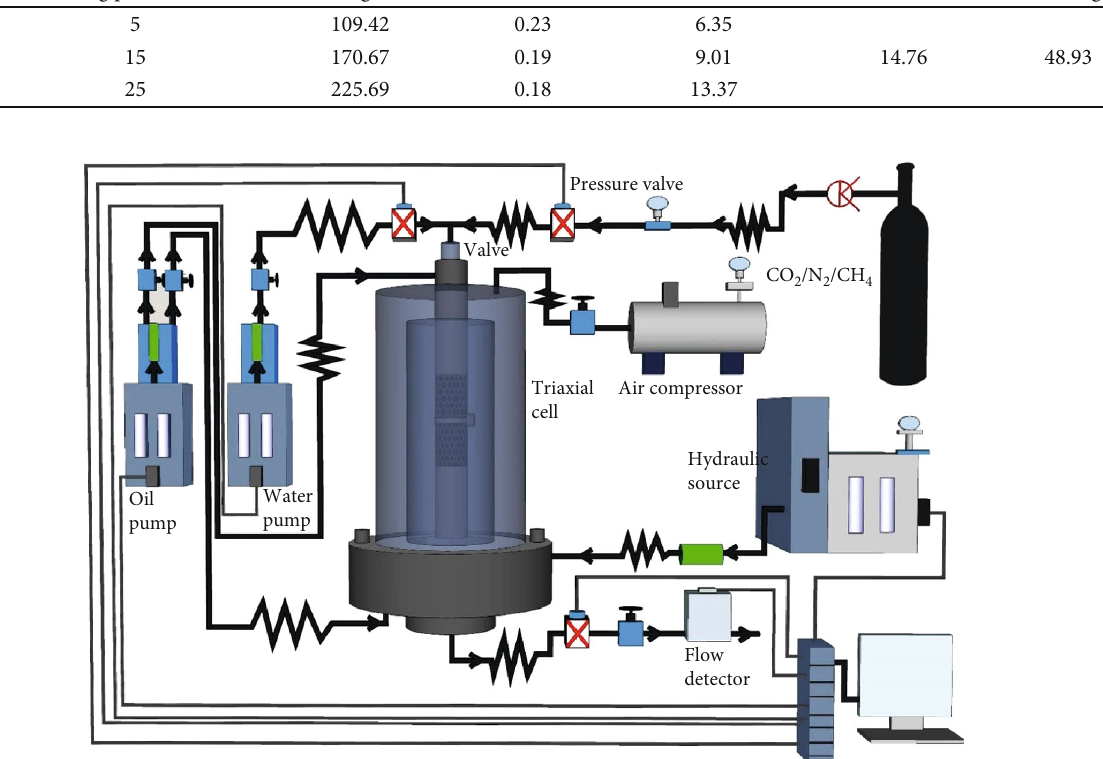
Figure 2: Triaxial hydromechanical coupling experimental